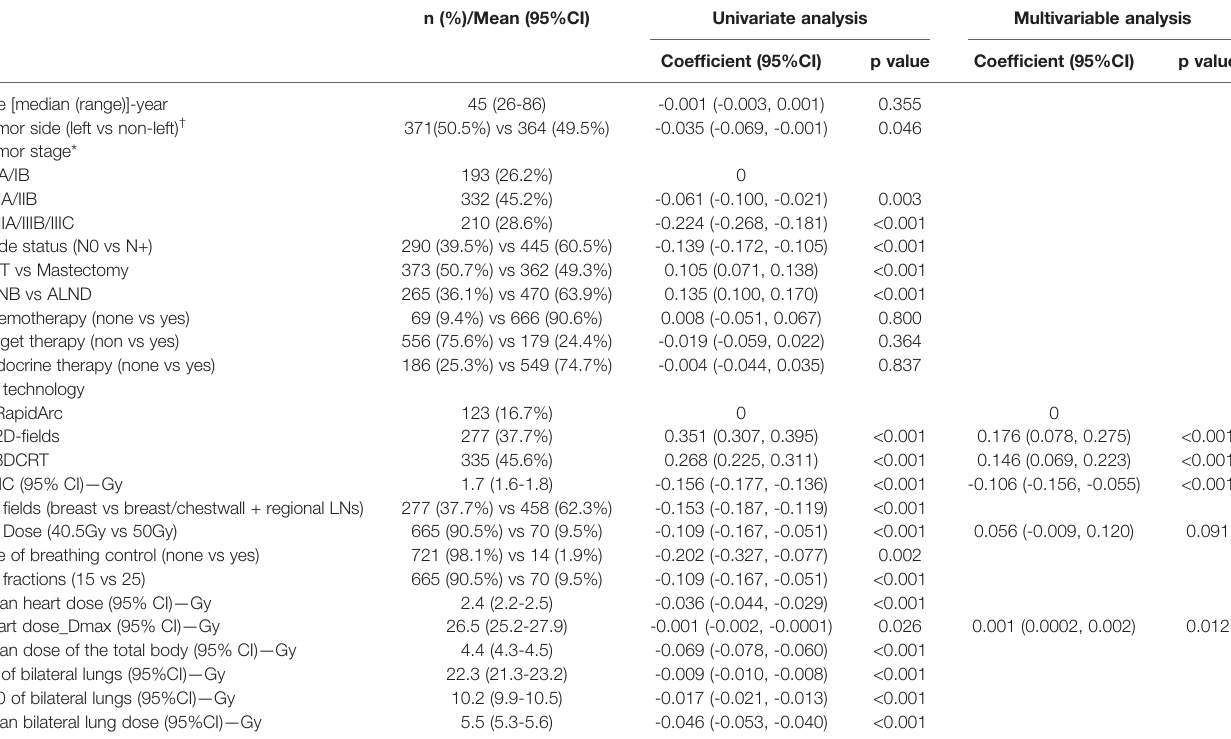
TABLE 1 | Patient characteristics, dosimetric factors and their predictive values on radiation induced lymphopenia (post/preRT PLC ratio). n (%)/Mean